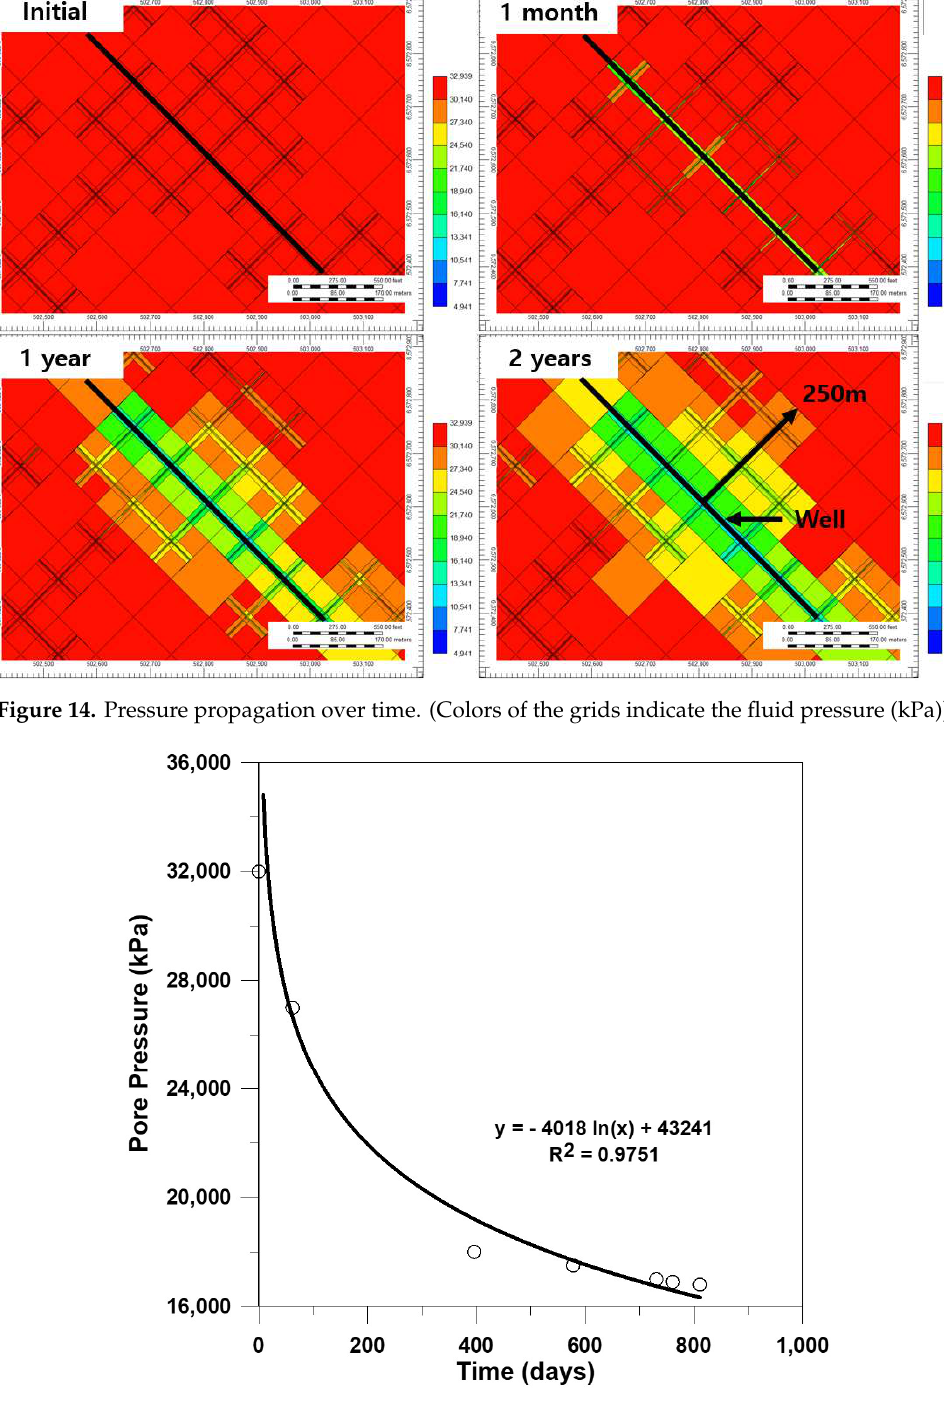
Figure 15. Average fracture fluid pressure in the flush SRV (FSRV) over time.